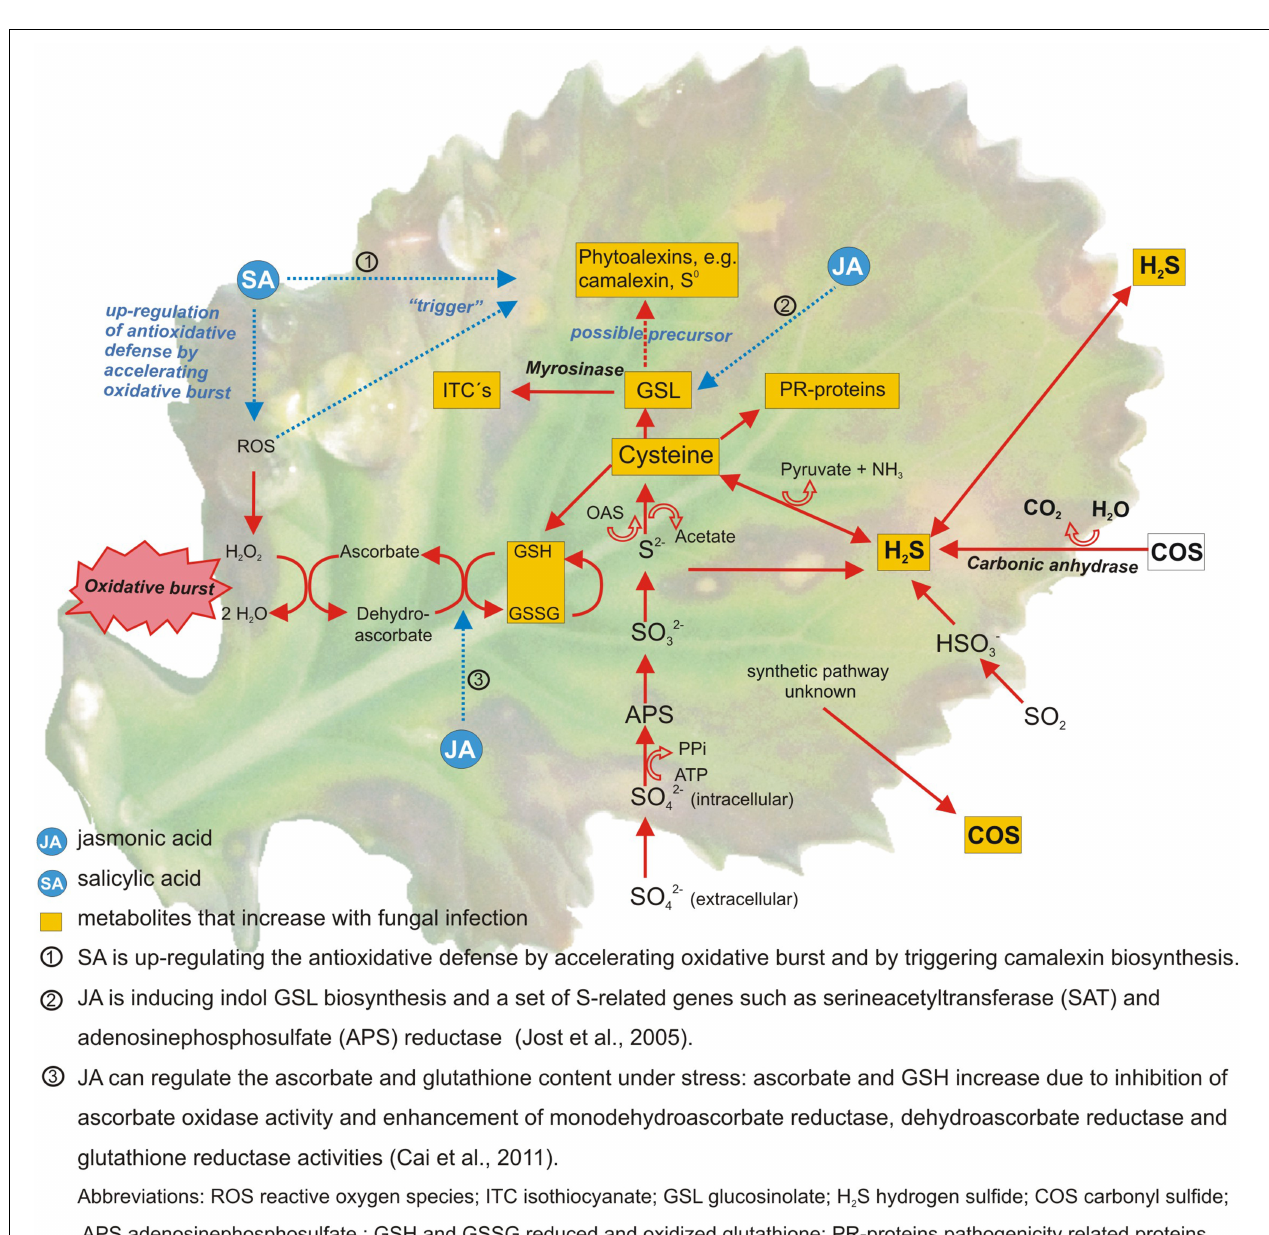
FIGURE 1 | Sulfur metabolites and pathways involved in the defense against fungal pathogens in Brassica species. Metabolites in yellow boxes were found to increase after fungal attack (Williams and Cooper, 2004; Glazebrook, 2005; Jost et al., 2005; Kruse et al., 2007; Bloem et al.,